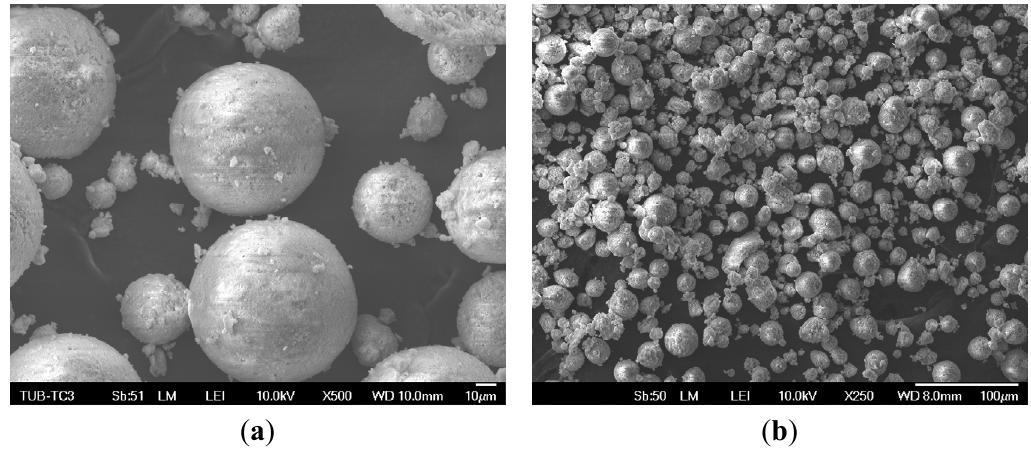
Figure 2. Spherical particles in entire granule-blends (EG) ( a ) and with irregularly shaped particles in fraction <32 ( b ).